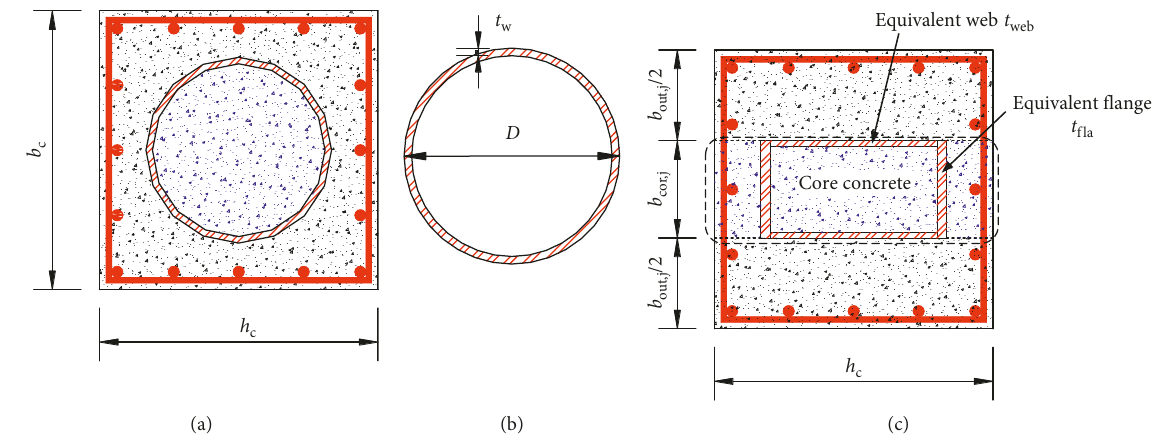
Figure 10: Section composition and equivalence of SRCFCST column section. (a) SRCFCST column section. (b) Circular steel tube. (c) Equivalence of SRCFCST column section.